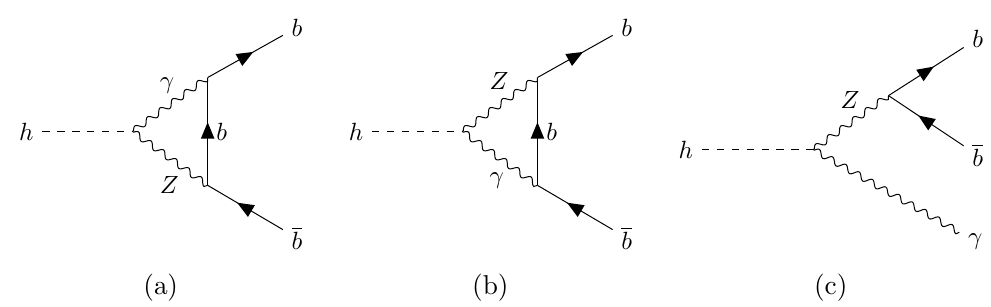
Figure 3 . Virtual (a, b) and real (c) corrections to the h ! bb decay rate due to the h(cid:13)Z vertex generated by the operators Q HB , Q HW and Q HWB